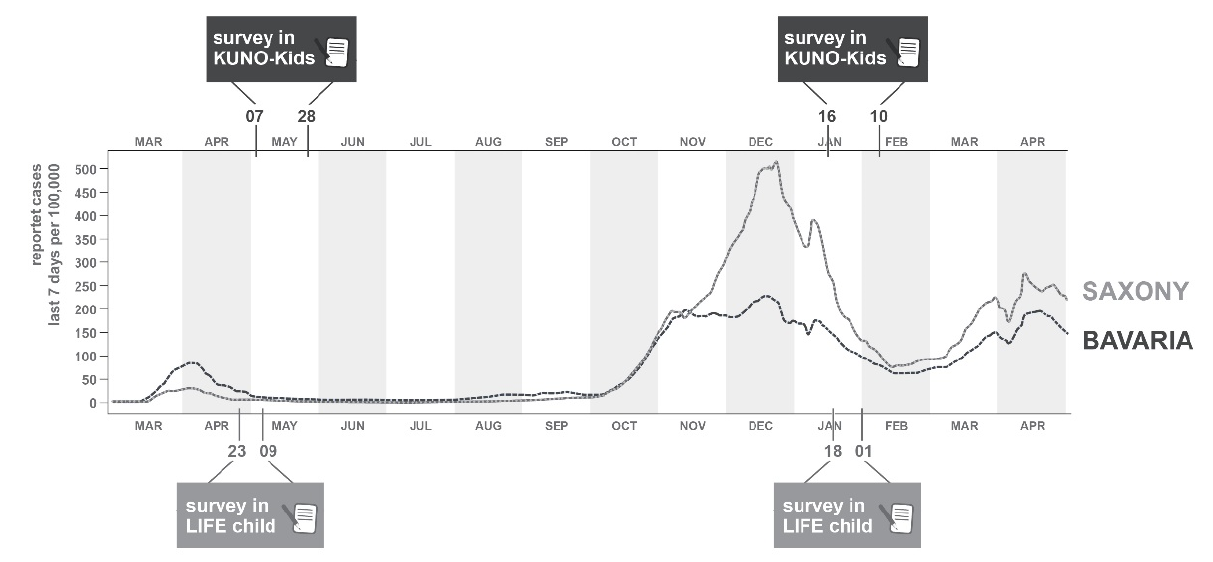
Figure 1. Course of COVID-19 incidence in Bavaria (for Regensburg) and Saxony (for Leipzig) and timing of online surveys.